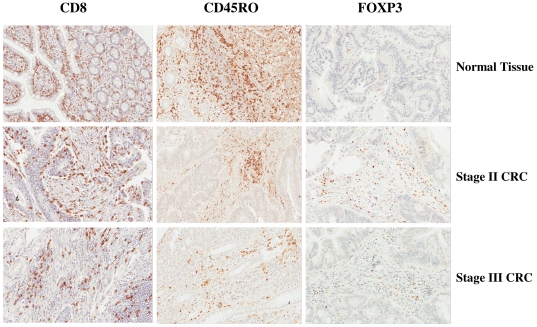
Representative images of CD8, CD45RO and FOXP3 staining in normal colonic tissue, stage II and III CRC.Images demonstrate DAB-stained tissue sections for CD8 positive cells, CD45RO-positive cells and FOXP3 positive cells. Images were taken at 20X scanning magnification.